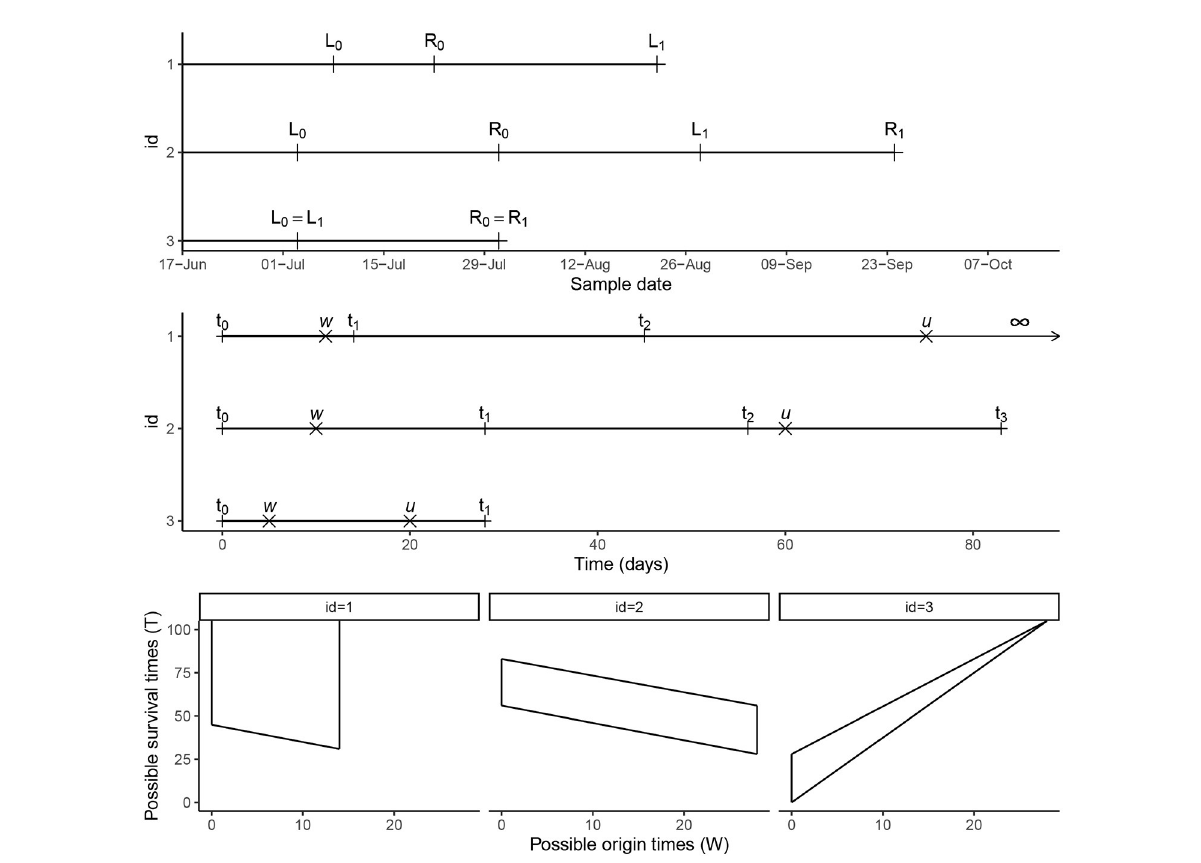
FIGURE2 Timeline. Conversion of calendar time data into follow-up time intervals for three participants from the malaria cohort and the possible survival times ( T ) representing the time from the initial infection to the event of